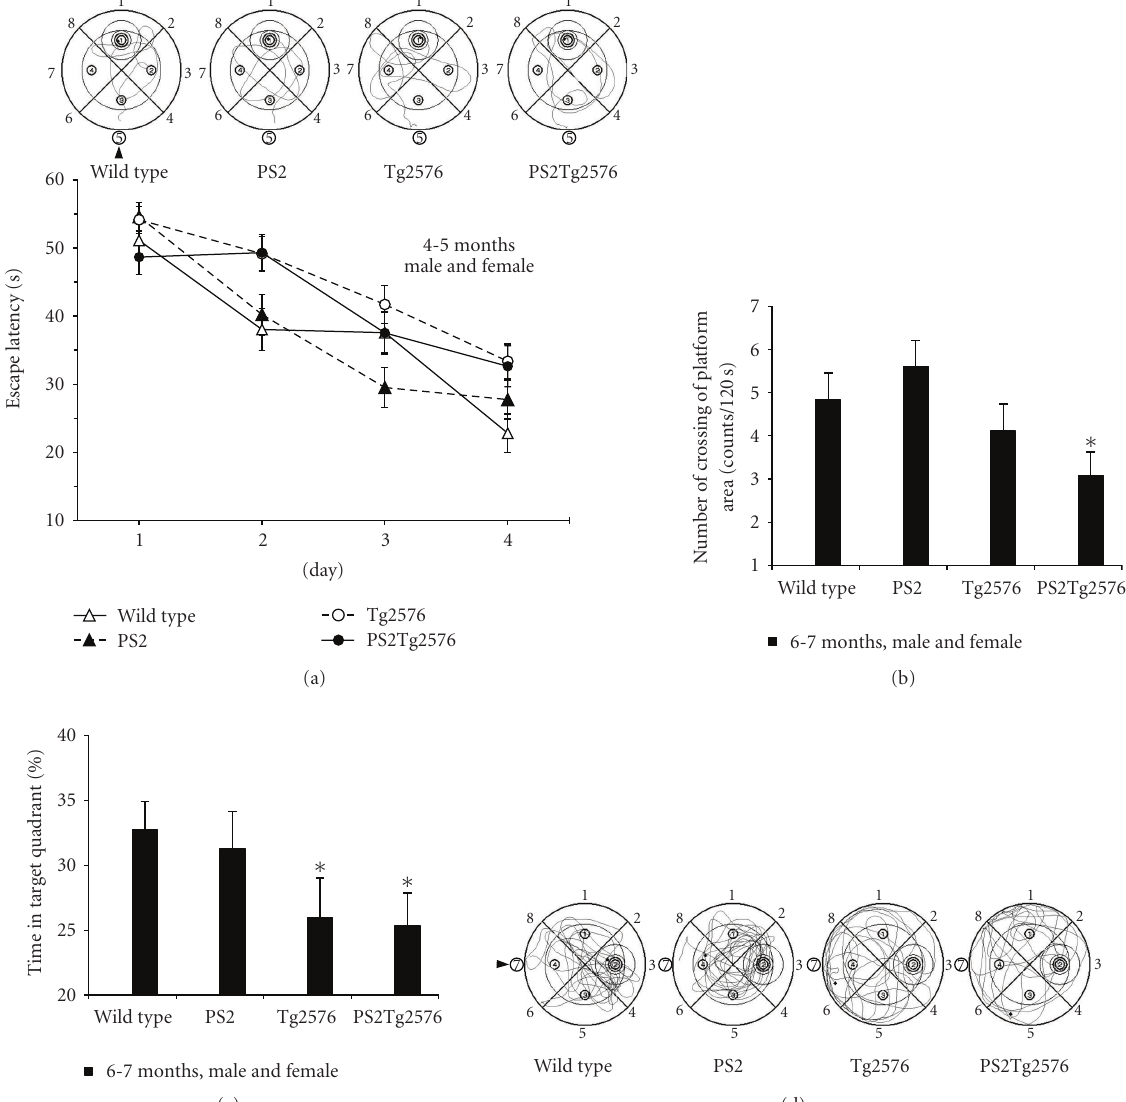
Figure 4: Morris water maze performed at 6-7-months of age using PS2Tg2576 mice. (a) The escape latency of the 6-7 month-old mice in the hidden platform trial. Training trials were repeated for 4 days (1 minute/trial, 4 trials/day). Only the PS2Tg2576 mice showed significant task errors on days 3 and 4 (using one-way ANOVA, ∗ P < . 05). The graph shows representative swimming paths of individual mice on day 4 of the training phase. (b) The number of crossings of the removed-platform area during the probe test. A probe trial, in which the platform was removed, was performed for 2 minutes on the day after the training trials had finished. (c) Percentage of time spent in the target quadrant during the probe trial. (d) Representative swimming paths of individual mice during the training phase of the probe test. The arrowhead represents the entry point. Values represent the mean ± s.e.m. ( n = 18-24, approximately equal numbers of male and female mixture). Statistical significance was assessed using the unpaired T -test (c, d): ∗ P < . 05 compared with the wild-type mice at the same